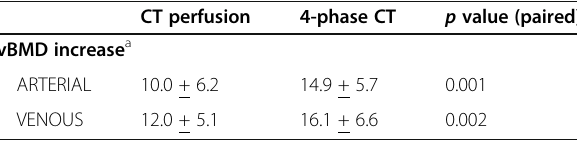
Table 1 Change in vBMD after contrast